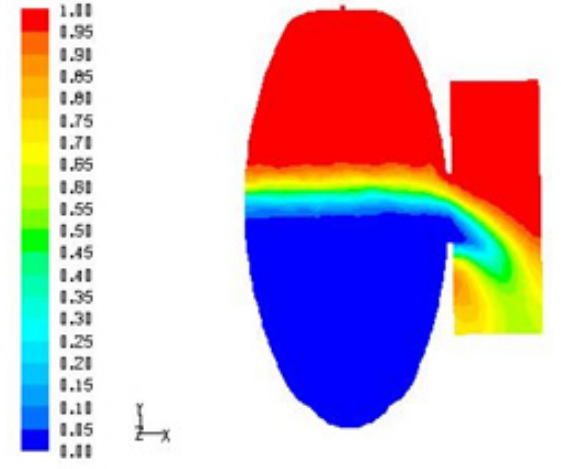
Fig. 4-1. Phase interface, Δ p = 2 kPa, reduced outlet. An unsuitable strong dynamic effect of the outgoing flow on the walls in the